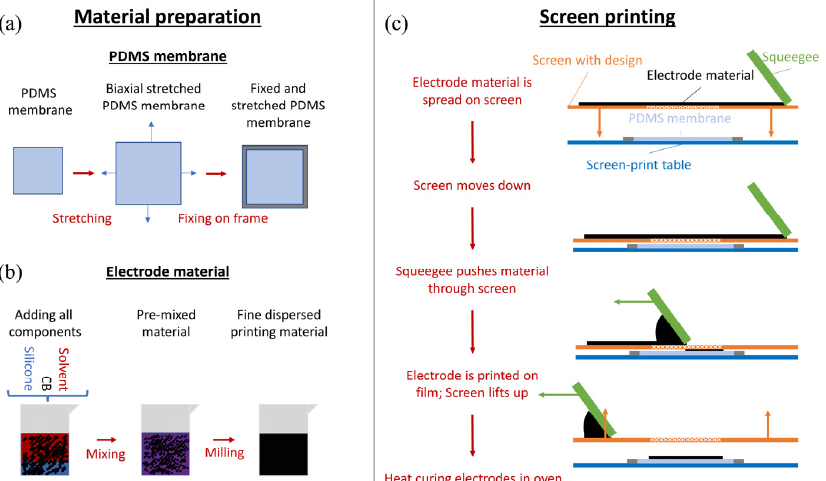
Figure 2. Schematic electrode manufacturing procedure: ( a ) Preparation of the silicone membrane. A piece of silicone membrane is stretched biaxially and then fixed between two metal frames, so that the center of the silicone film is not covered by the metal; ( b ) Preparation of electrode material. First, all components of the electrode ink are added into a cup, pre-mixed with a Thinky planetary mixer and subsequently milled with a three-roll mill to homogenize the printing ink; ( c ) Steps for screen-printing electrodes. The printing ink is spread over the screen with the desired design. The screen moves close to the silicone membrane. The squeegees move with a specific printing pressure over the screen and squeezes the material through the screen onto the silicone membrane. Subsequently, the screen lifts up again and the frame is transferred into the oven for curing.